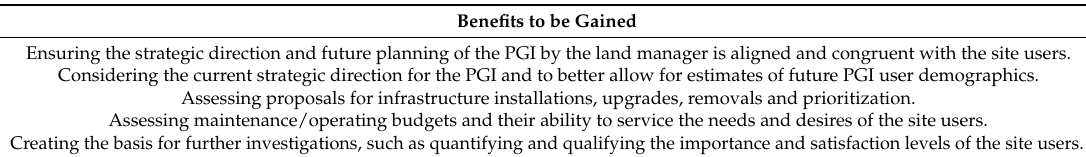
Table 3. Hierarchy of benefits to be gained from understanding the demographics of PGI users. Benefits to be